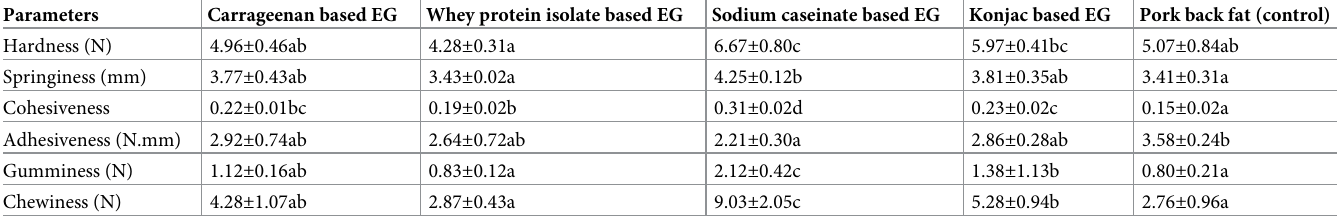
� Values are given as mean ± standard deviation (SD) from triplicate determinations. Different letters in the same row indicate significant differences (p <